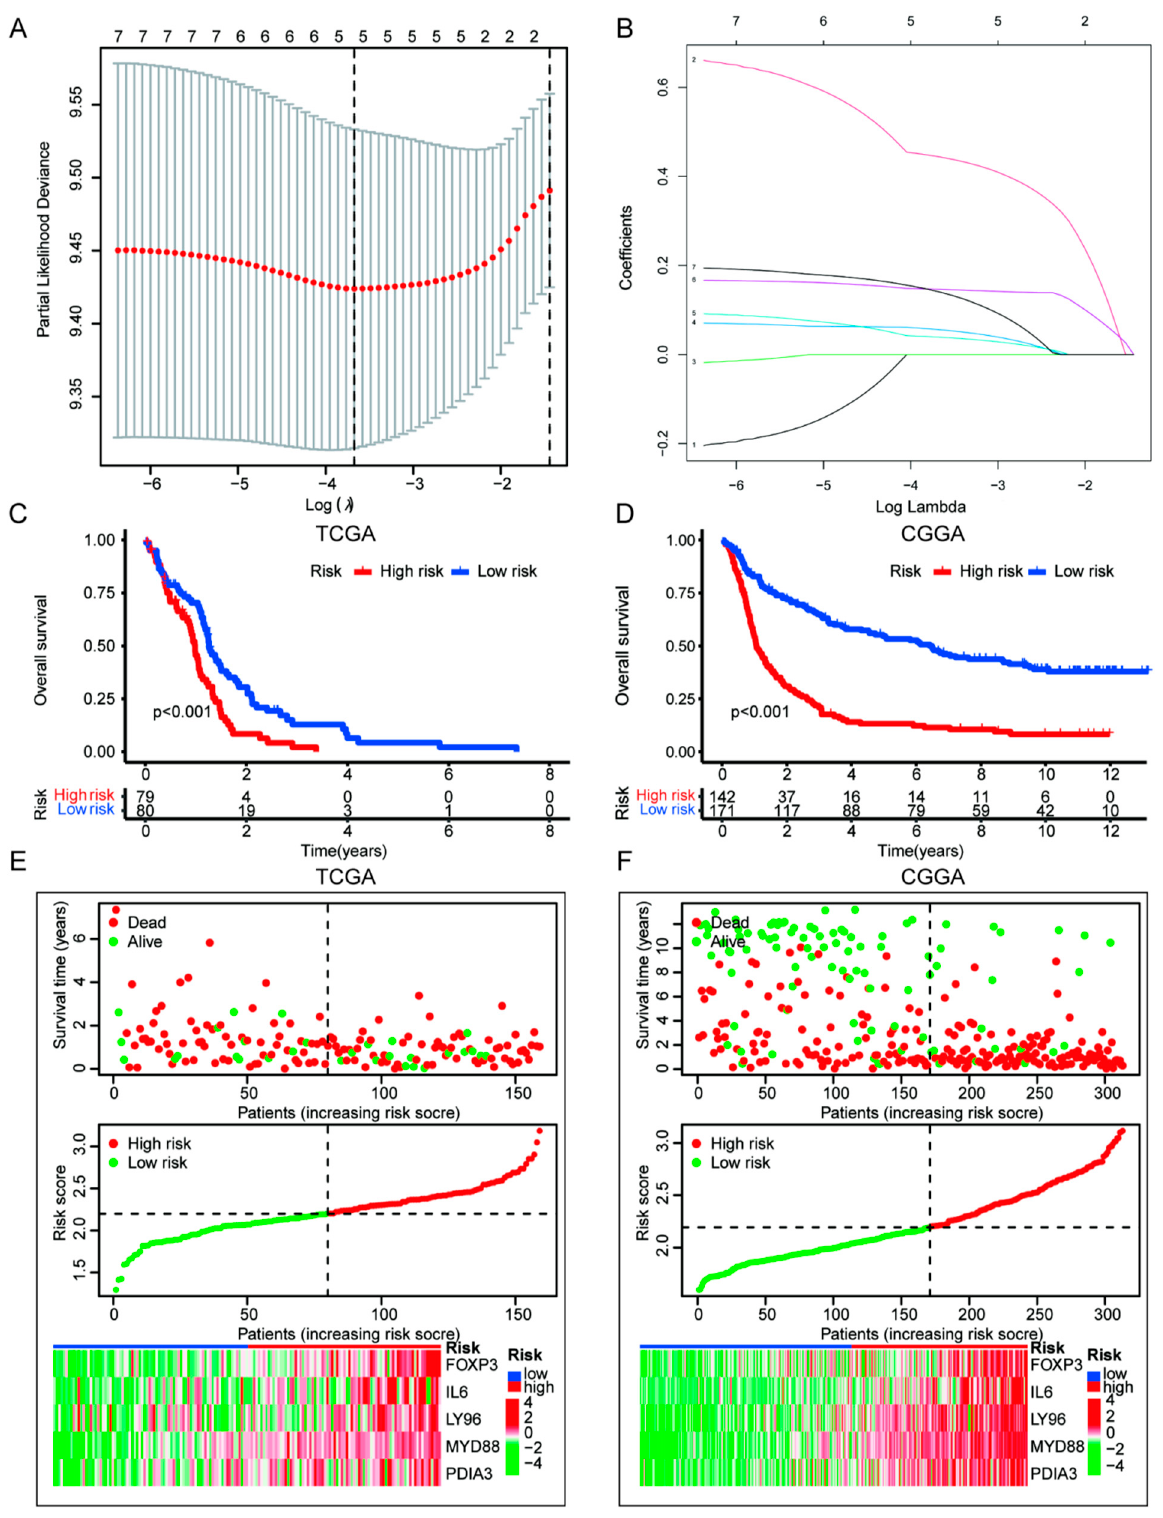
Figure 6. Construction and validation of the ICD risk signature in TCGA and CGGA database. ( A , B ) LASSO regression of the most associated genes with OS in TCGA. ( C , D ) Kaplan–Meier analyses in TCGA and CGGA databases. ( E , F ) Survival status, risk scores distribution, and heatmaps of five prognostic gene signatures of each patient in TCGA and